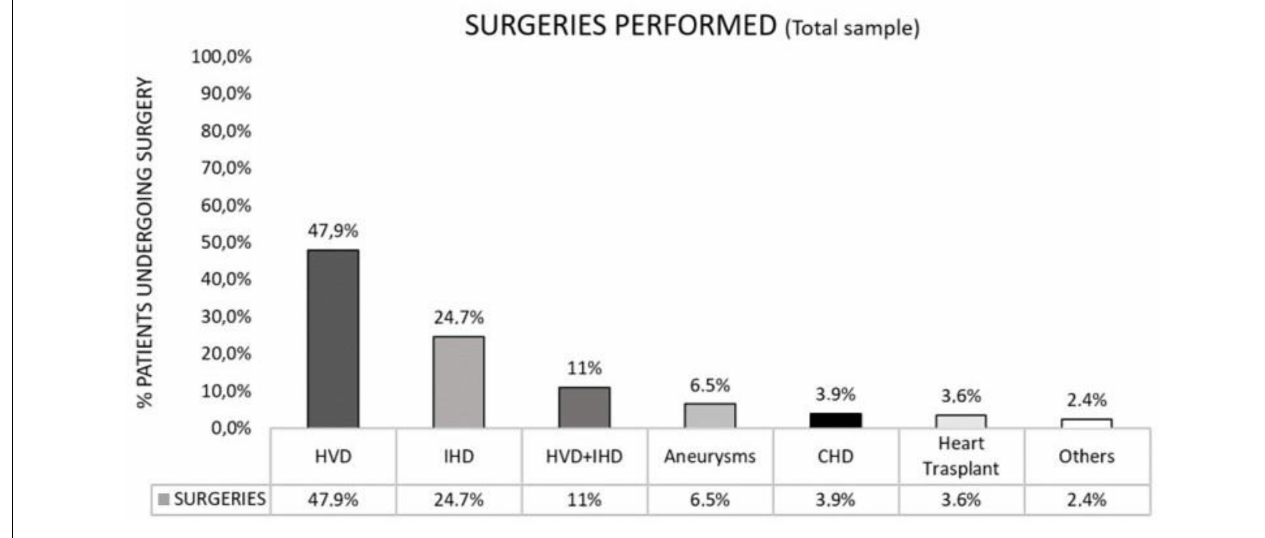
FIGURE 2 | Surgeries performed among the study population.